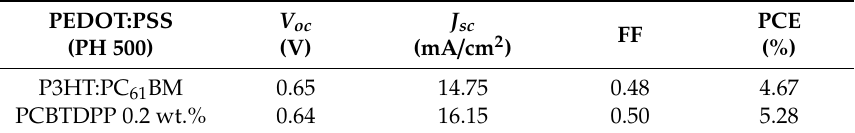
Table 2. Summary of PV performances of the devices based on highly conductive PEDOT:PSS (PH 500) with 5% DMSO.